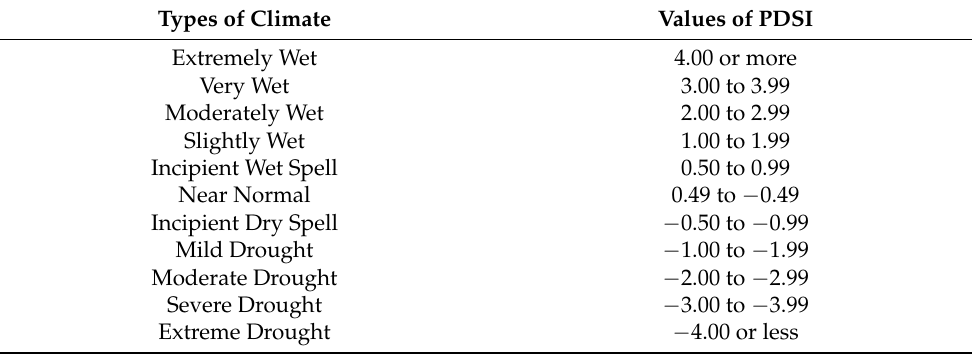
Table 1. Drought classification for the Palmer Drought Severity